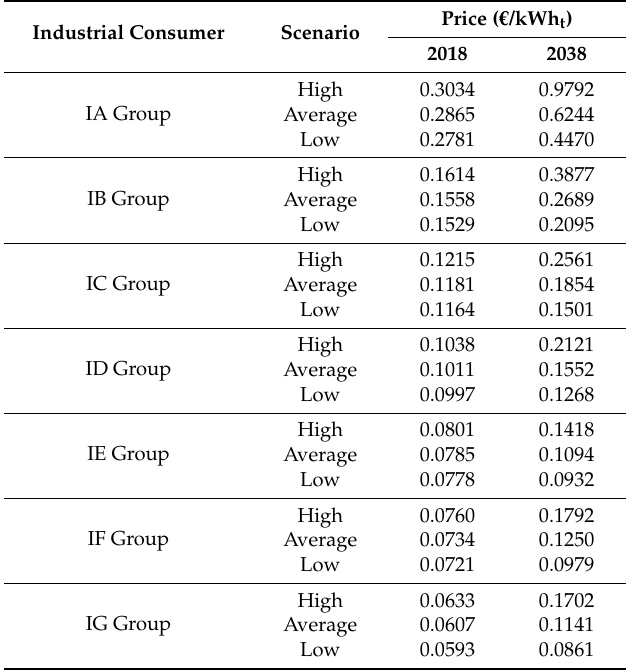
Table 10. Electricity price forecast,